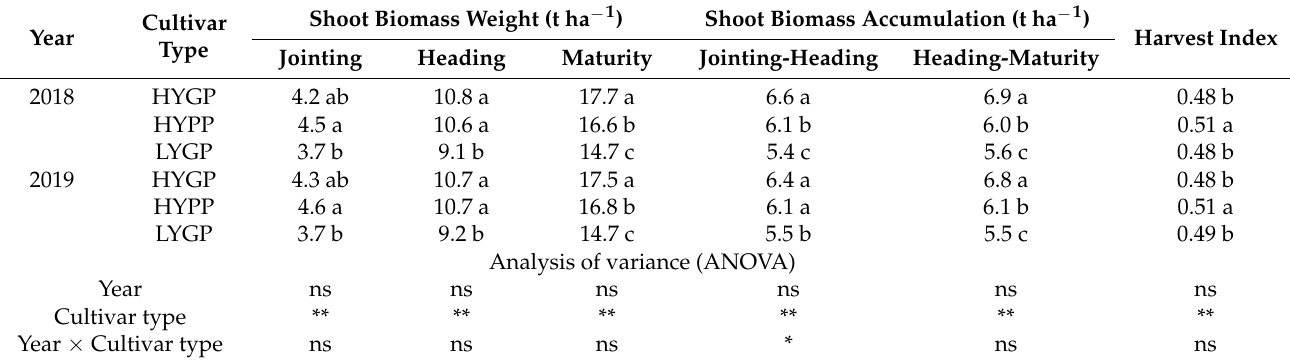
Table 3. Shoot biomass weight and accumulation and harvest index of rice cultivar